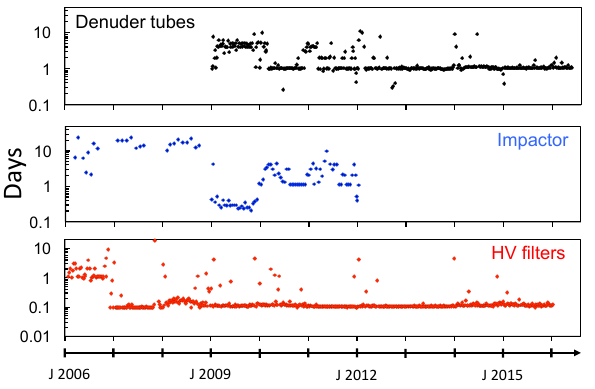
Figure 1. Time (in days, logarithmic scales) spent between two suc- cessive samplings for acidic gases (denuder tubes), size-segregated (12-stage impactor) and bulk (HV filters) aerosol composition at Concordia (2006–2015) (Sect. 2).